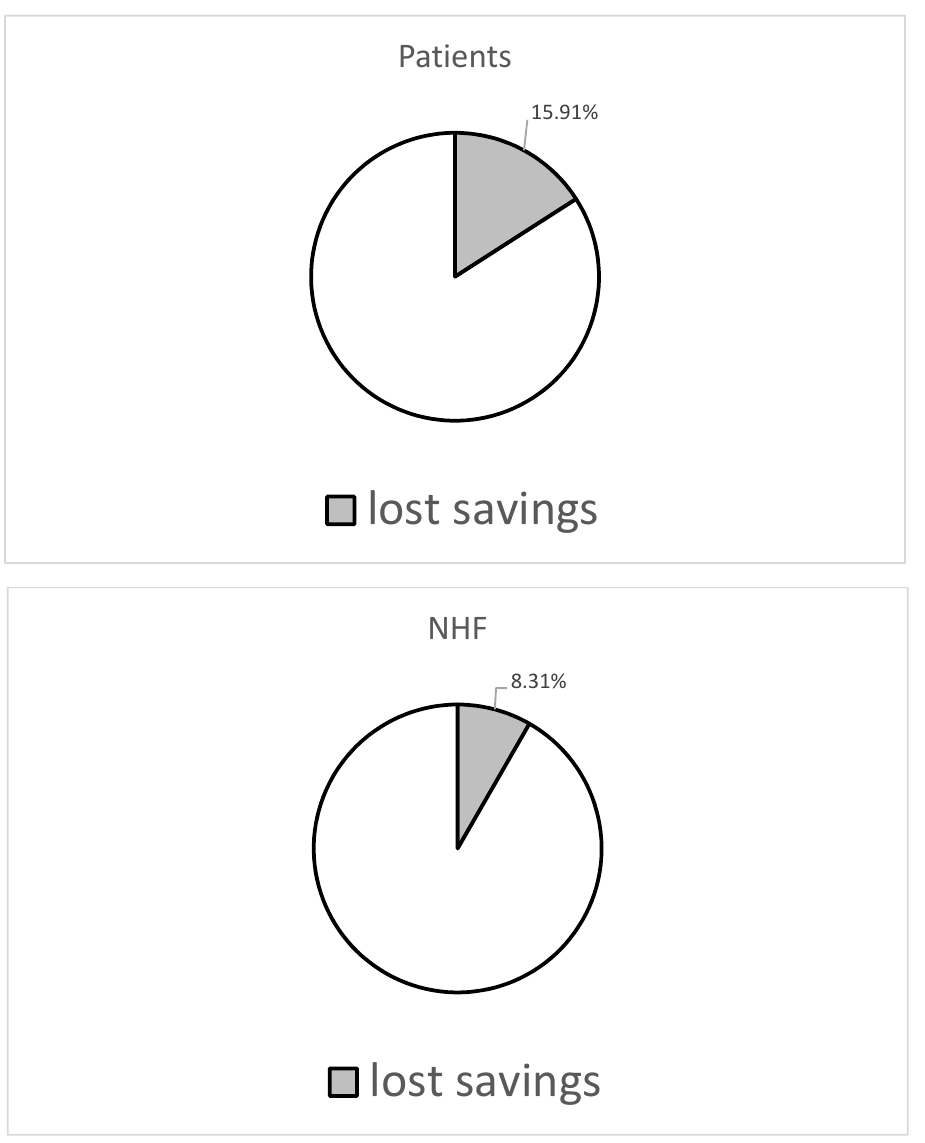
Figure 2. Potential savings that could be achieved by both the patients and the payer due to optimal use of generic substitution, expressed as the percentage of total co-payment (patients) and the percentage of total reimbursement (NHF), corresponding to all metformin prescriptions dispensed in 2019 in Poland. NHF—National Health Fund.